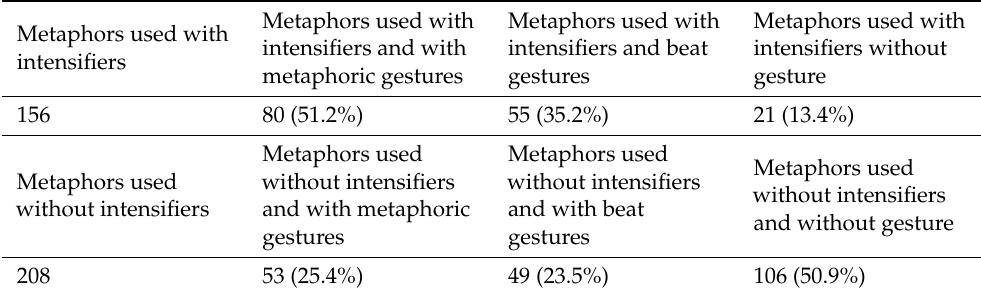
Table 2. Number of metaphors used with/without intensifier and with metaphoric/beat gestures. Metaphors used with Metaphors used with Metaphors used with Metaphors used with intensifiers without intensifiers and beat intensifiers and with intensifiers gesture gestures metaphoric gestures 156 80 (51.2%) 55 (35.2%) 21 (13.4%) Metaphors used Metaphors used Metaphors used without intensifiers without intensifiers Metaphors used without intensifiers and with beat and with metaphoric without intensifiers and without gesture gestures gestures 208 53 (25.4%) 49 (23.5%) 106